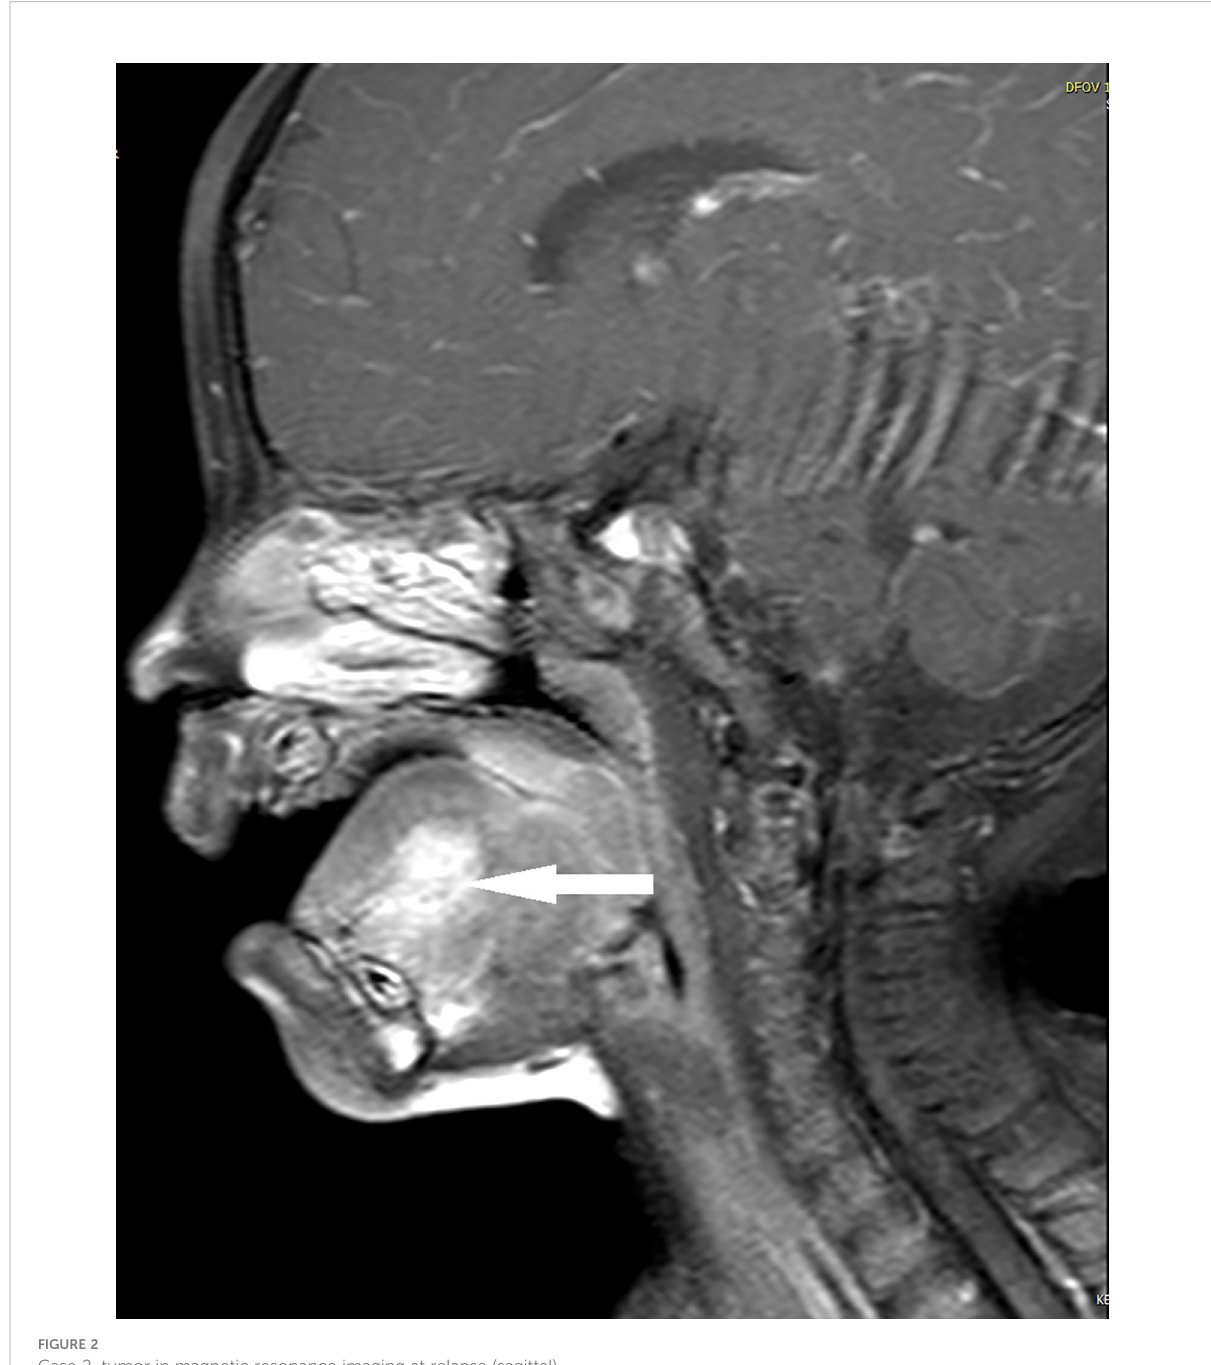
FIGURE 2 Case 2, tumor in magnetic resonance imaging at relapse